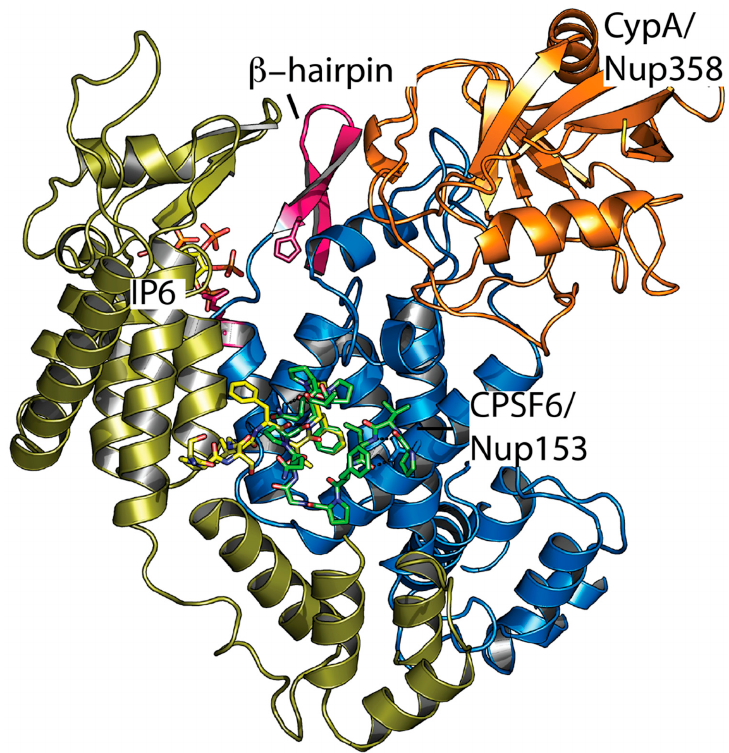
Figure 3. Ligand interaction sites on two adjacent monomers in the mature HIV-1 capsid hexamer. Superposition of complexed structures of CPSF6 (4U0B), Nup153 (4U0C), Nup358 (4LQW), and IP6 (6ES8). Two hexamer monomers are shown in blue and gold, CypA/Nup358 in orange, CPSF6 and Nup153 peptides in green and yellow, IP6 as atom colored sticks, and the β -hairpin in pink.